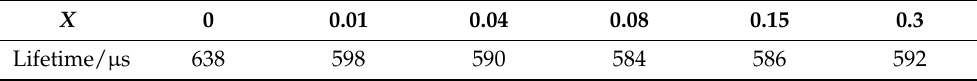
Table 1. Luminescence decay lifetime of the GOS:Tb, x F scintillators as a function of x . X 0 0.01 0.04 0.08 0.15 0.3 Lifetime/ µ s 638 598